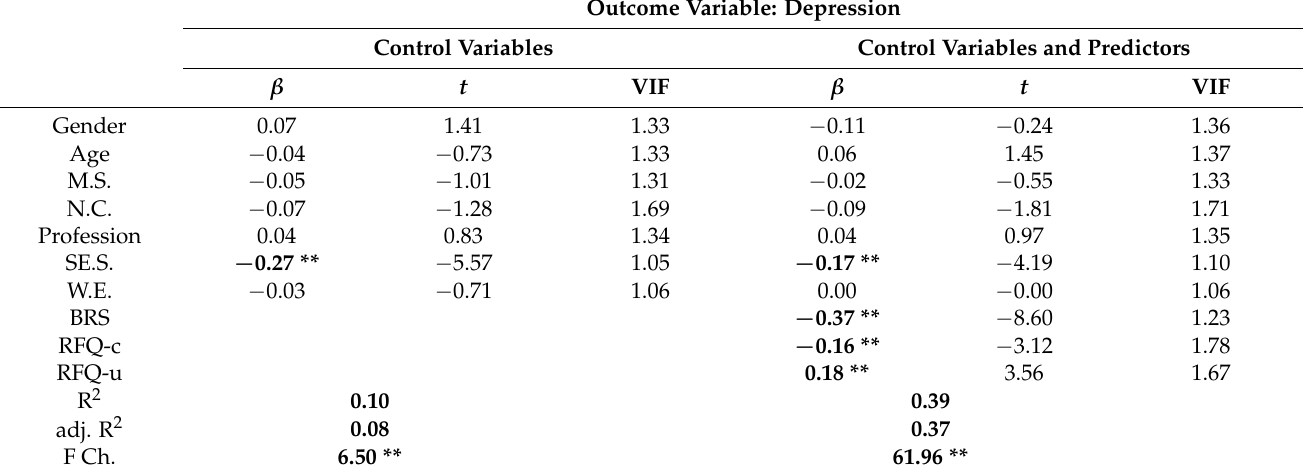
Table 4. Hierarchical linear regression analysis of the relationship among DASS-42 dimensions, resilience, and